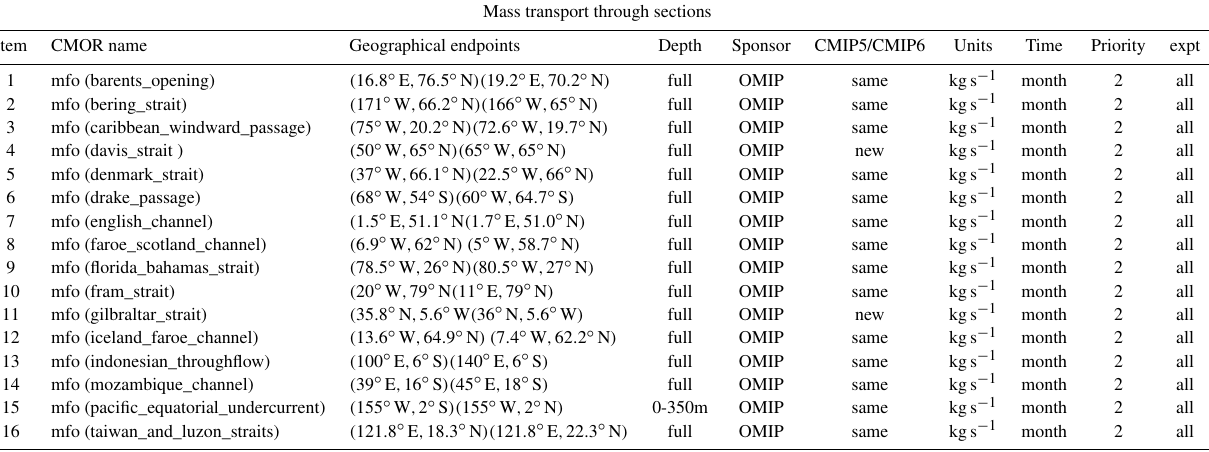
Table J1. This table summarizes the sections for archiving the depth-integrated mass transport time series from the ocean component in CMIP6 simulations. Each time series is identified by the CF standard name sea_water_transport_across_line. Additionally, each geograph- ical region has an associated string-valued coordinate given by the name in this table. All time series should be saved as monthly means in units of kgs − 1 . Positive and negative numbers refer to total northward/eastward and southward/westward transports, respectively. The column indicating the experiment for saving the diagnostics generally says “all”, in which case we recommend the diagnostic be saved for CMIP6 experiments in which there is an ocean model component, including the DECK, historical simulations, FAFMIP, DAMIP, DCPP, ScenarioMIP, and C4MIP, as well as the ocean/sea-ice OMIP